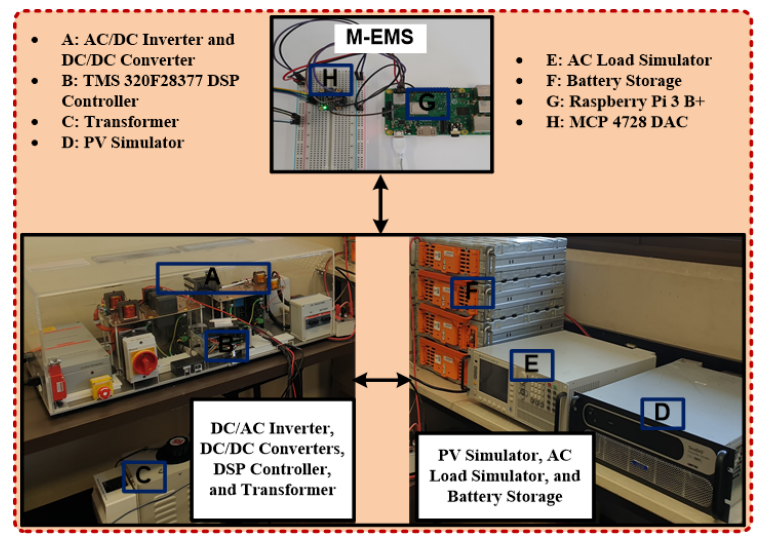
Figure 5. Experimental